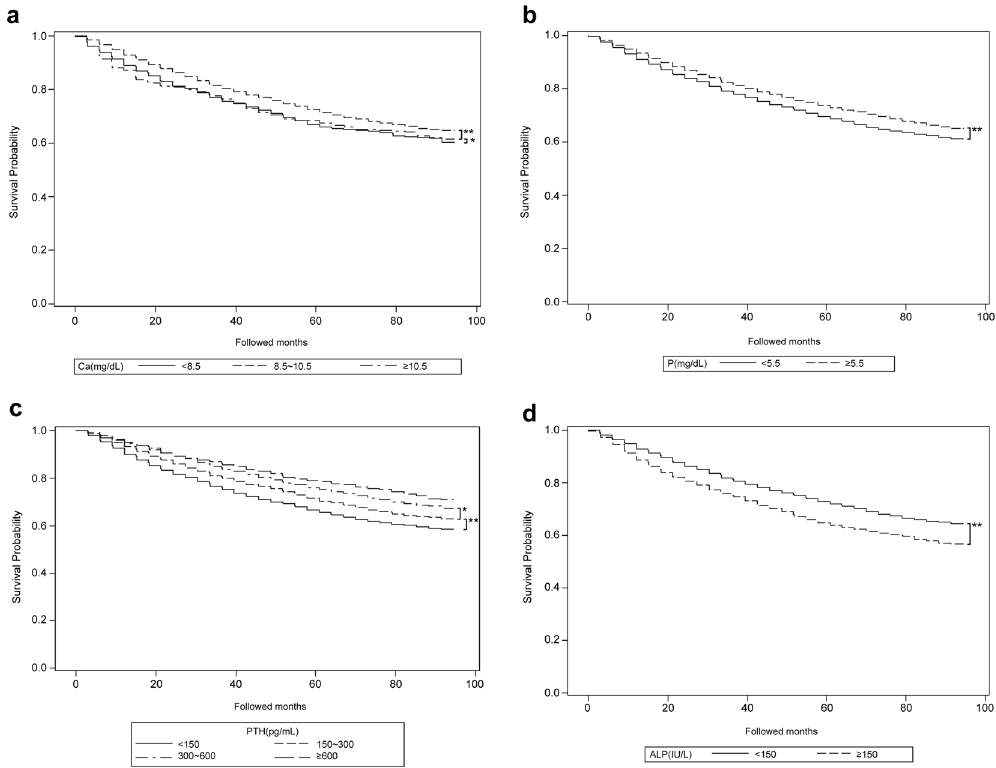
Figure 2. Kaplan-Meier curves showing the survival of peritoneal dialysis patients in Taiwan categorized by CKD-MBD biomarkers. Significance was tested by log-rank test. ( a ) Grouped by serum calcium ( b ) Grouped by serum phosphorus ( c ) Grouped by serum PTH ( d ) Grouped by serum total ALP. CKD-MBD, chronic kidney disease-mineral bone disorder; PTH, parathyroid hormone; ALP, alkaline phosphatase. Multiple comparison was performed by Sidak correction. ** p < 0.0001; * p < 0.05.